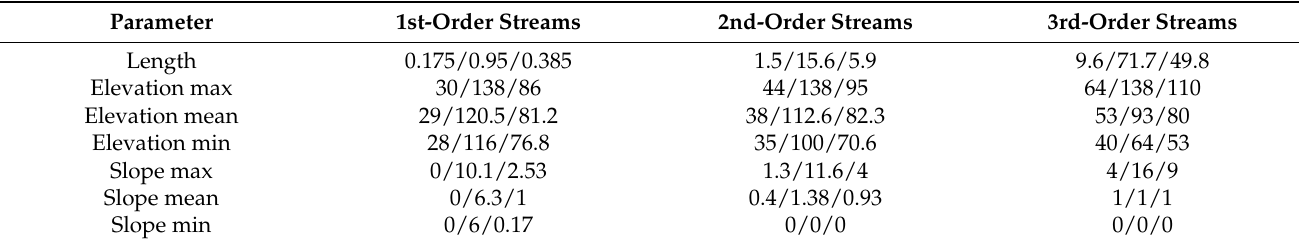
Table 3. Morphometrical results associated with streams and encompassing length (km), elevations (m asl) and slopes ( ◦ ). Parameter Length